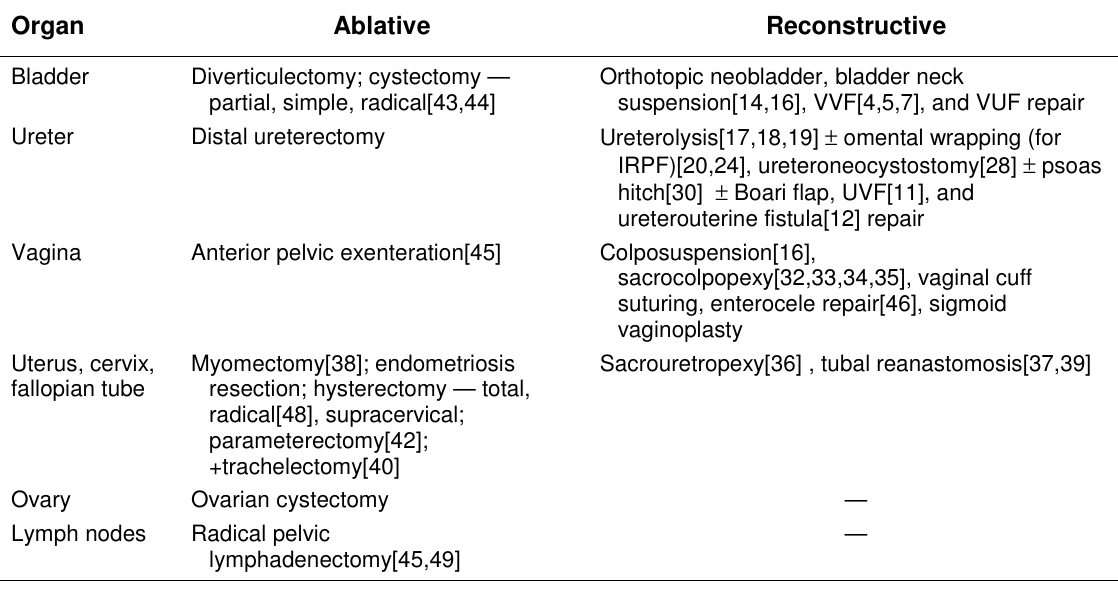
List of Laparoscopic Procedures Performed in the Female Pelvis With and Without Robotic